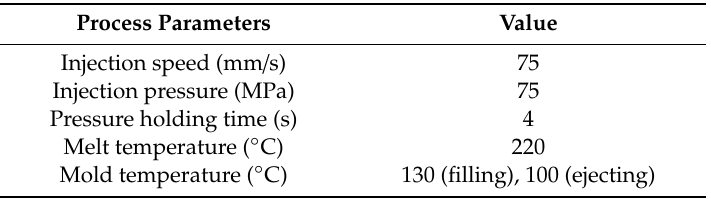
Table 1. Parameter settings for complete filling.